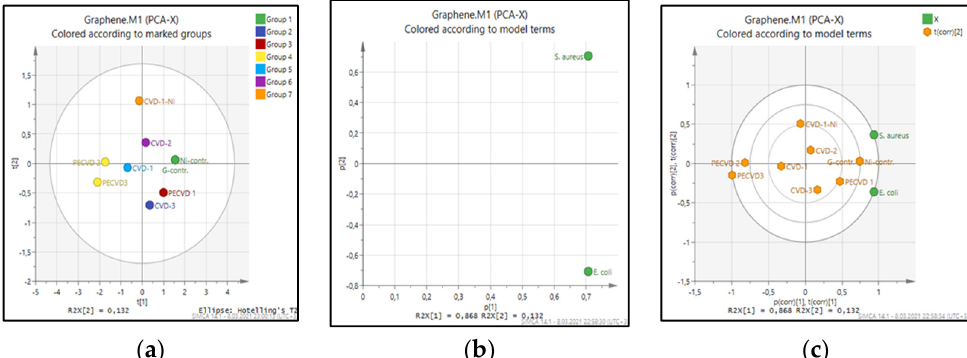
Figure 11. Score scatter plot ( a ), loading scatter plot ( b ), and biplot ( c ) of principal component analysis (PCA) (PC1 versus PC2) for the attributes in the samples.